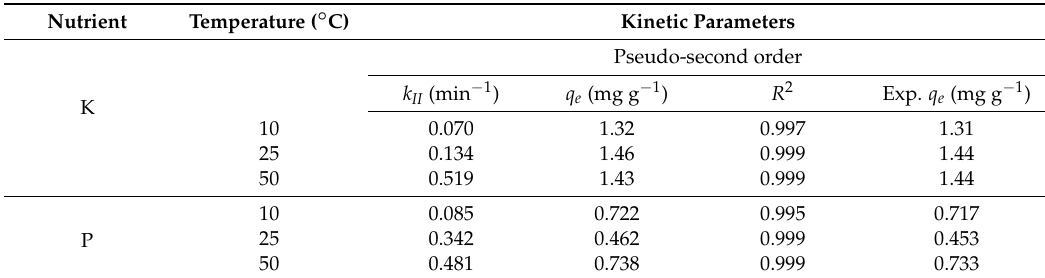
Table 2. Kinetic data for MgAl 200 /K 2 HPO 4 material.